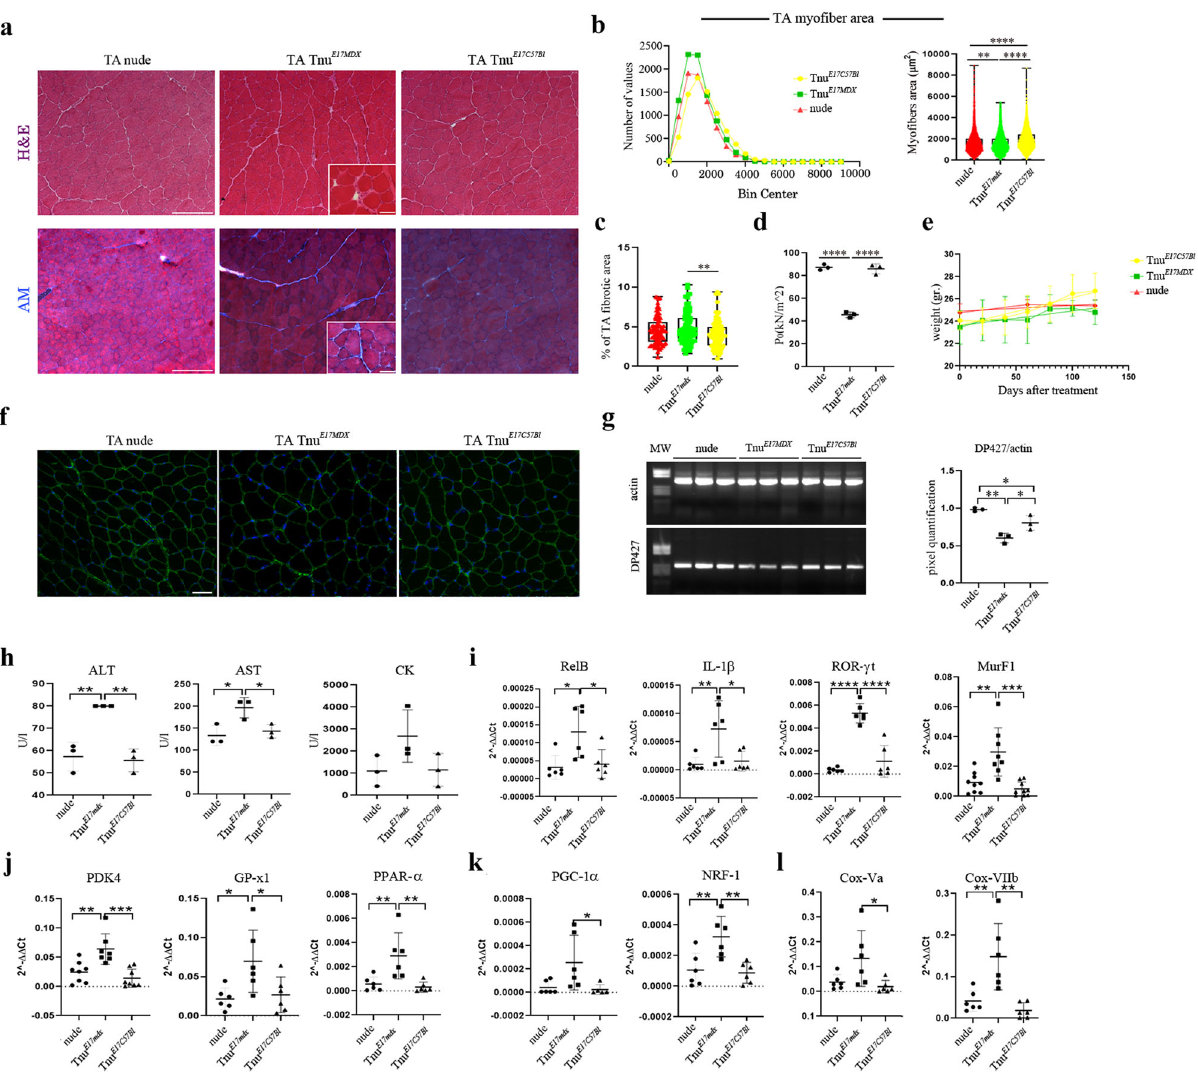
Fig. 10 Morphometric and functional analysis of skeletal muscles of nude mice following foetal thymus transplantation. Representative images of H&E and AM staining of TAs from nude, Tnu E17MDX , Tnu E17C57Bl mice ( a ). Quanti fi cation of the relative frequency of the myo fi ber CSA expressed as the frequency distribution of TA muscles of nude, Tnu E17MDX , Tnu E17C57Bl mice (Tnu E17C57Bl : minimum, median, maximum and range: 98.07, 1763, 8676, 8578, respectively; 25% percentile, 75% percentile, coef fi cient of variation: 1231, 2434, 47.44%, respectively. Tnu E17MDX : minimum, median, maximum and range: 81.53, 1421, 5449, 5367 respectively; 25% percentile, 75% percentile, coef fi cient of variation: 962.9, 2021, 51.27%, respectively. nude: minimum, median, maximum and range: 101.7, 1461, 8946, 8845, respectively; 25% percentile, 75% percentile, coef fi cient of variation: 982.2, 2029, 54.19%, respectively) ( b ). Quanti fi cation of fi brotic areas of TA muscles of nude, Tnu E17MDX , Tnu E17C57Bl mice (mean area: nude: 4.534; Tnu E17MDX :